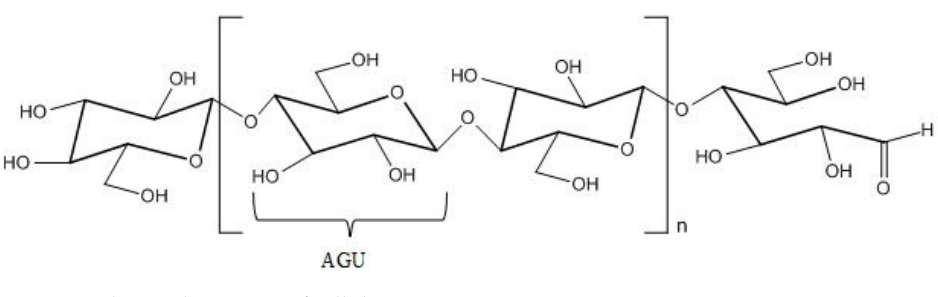
Figure 2. Chemical structure of cellulose. Table 1. Important physico-chemical properties of cellulose depending on the